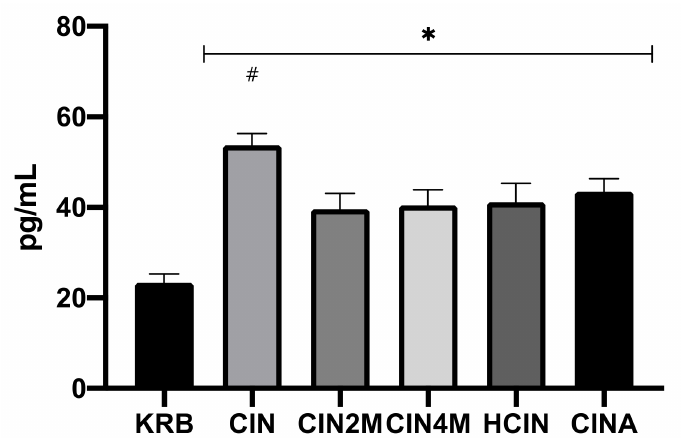
Figure 4. Effect of control KRB buffer (KRB), cinnamaldehyde (200 µ mol L − 1 , CIN), 2- methoxycinnamaldehyde (200 µ mol L − 1 , CIN2M), 4-methoxycinnamaldehyde (200 µ mol L − 1 , CIN4M), hydrocinnamaldehyde (200 µ mol L − 1 , HCIN) and cinnamic acid (200 µ mol L − 1 , CINA) on CCK release in the duodenum. Significant differences compared to control (KRB) are indicated with asterisks: * p < 0.05. Significant differences compared to all treatments are indicated with a hash: # p < 0.05. Number of replicates was n = 6, error bars express the